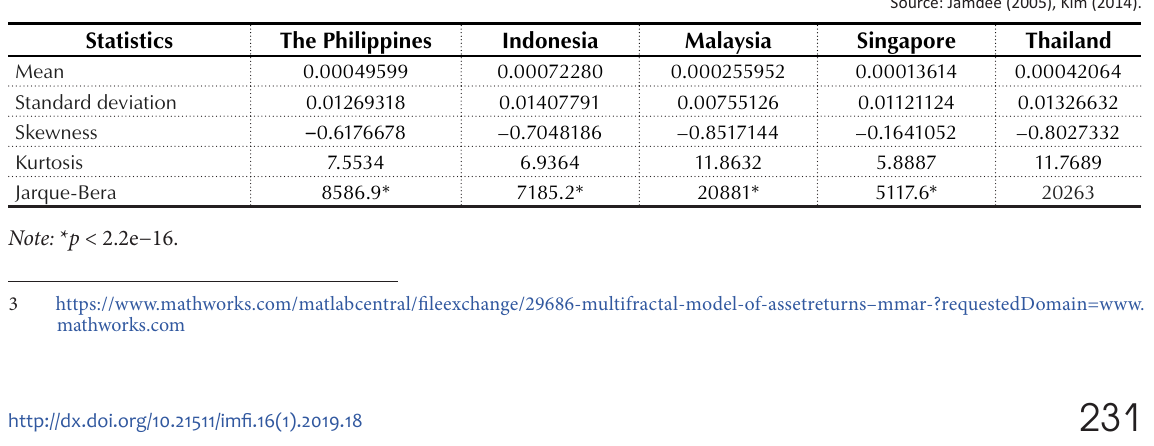
Table 2. The model return series estimation